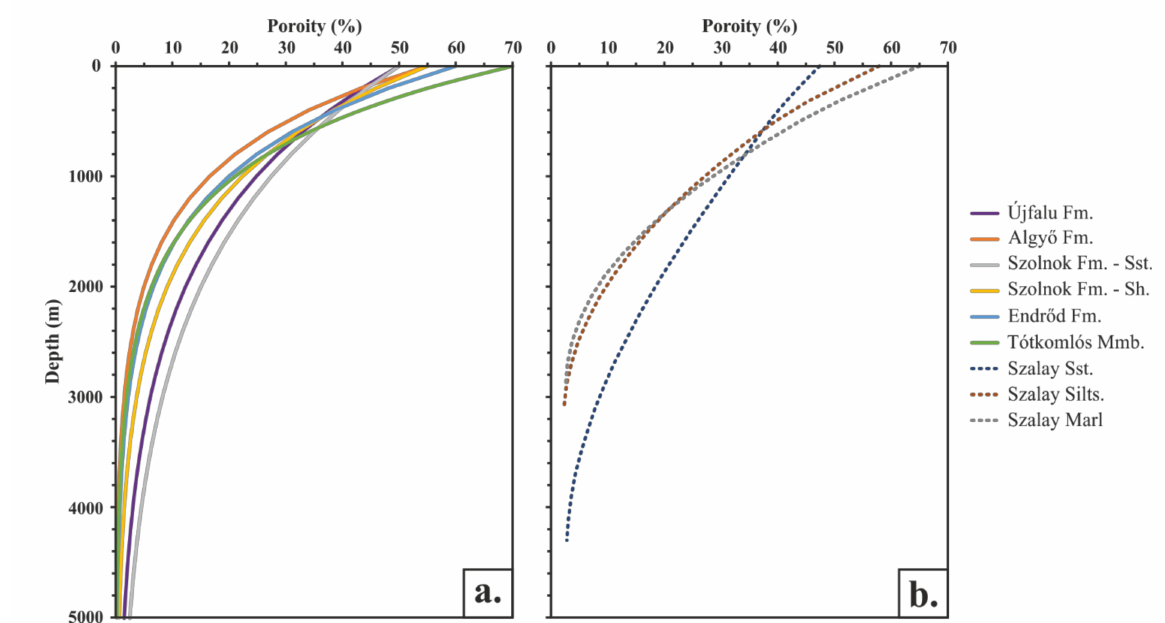
Figure 14. Porosity-depth trends of the main Late Miocene and Pliocene lithostratigraphic units to describe the mechanical compactions of different sediments: ( a ) proposed trends that rely on well log-based and measured porosity data; ( b ) Szalay’s compaction trends for marls, siltstones, and